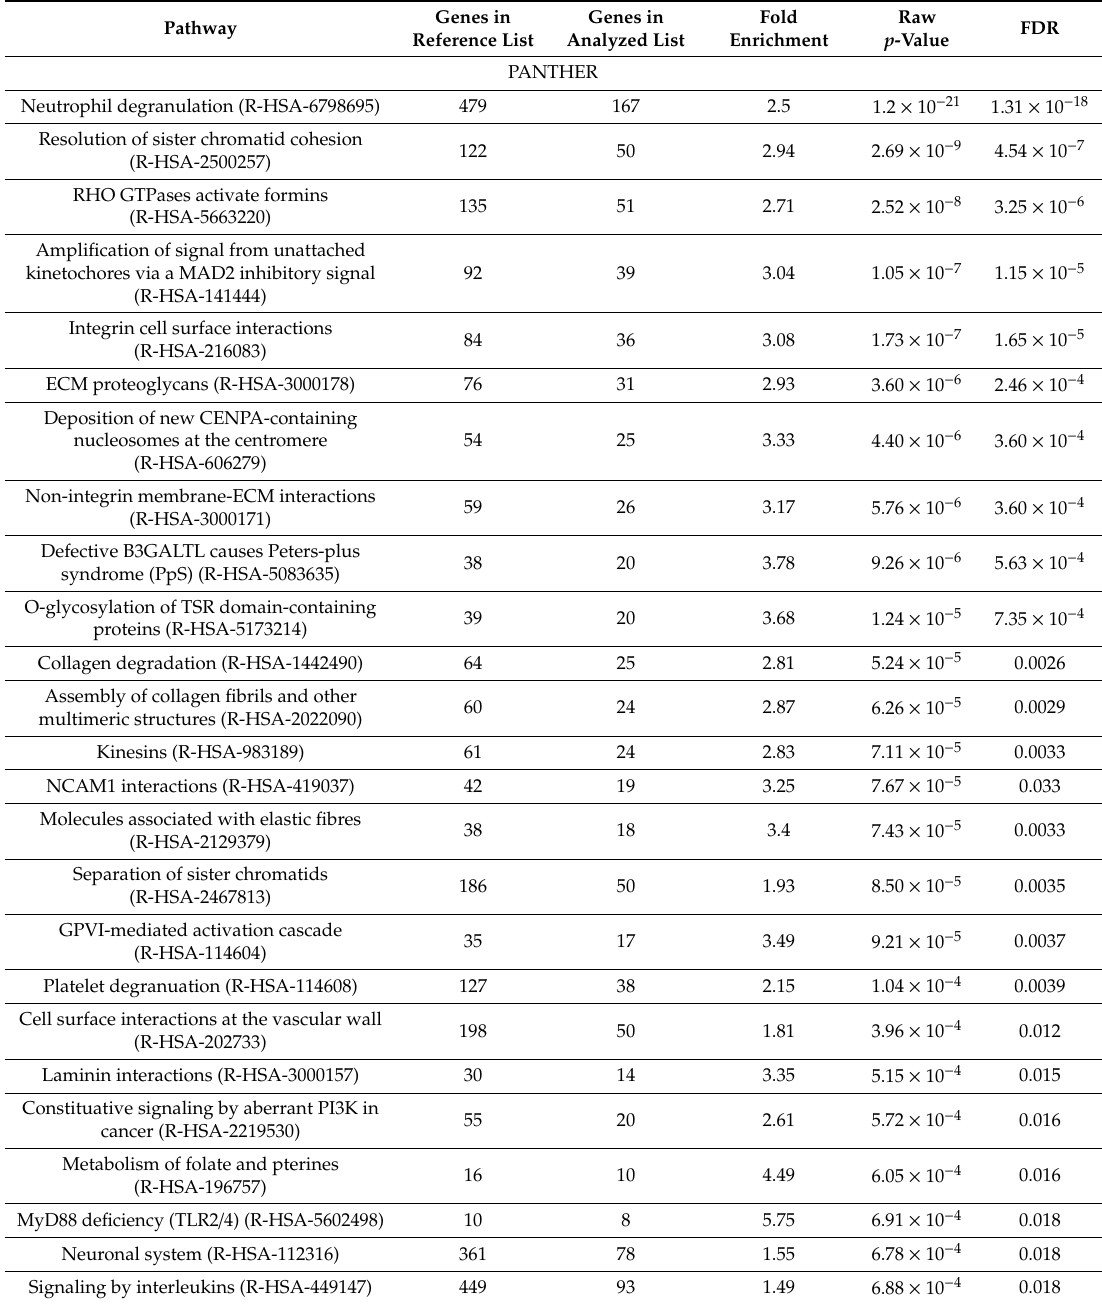
Table 6. Results from pathway analysis in PANTHER and Reactome. Only the top 25 (by FDR) terminal hierarchical pathways from the PANTHER analysis are listed here; the complete hierarchical list of enriched pathways can be found in Table S7 . Fold-enrichment is not reported by Reactome (NA = not applicable). FDR = false discovery rate; ECM = extracellular matrix; R-HSA-XXX = Reactome pathway